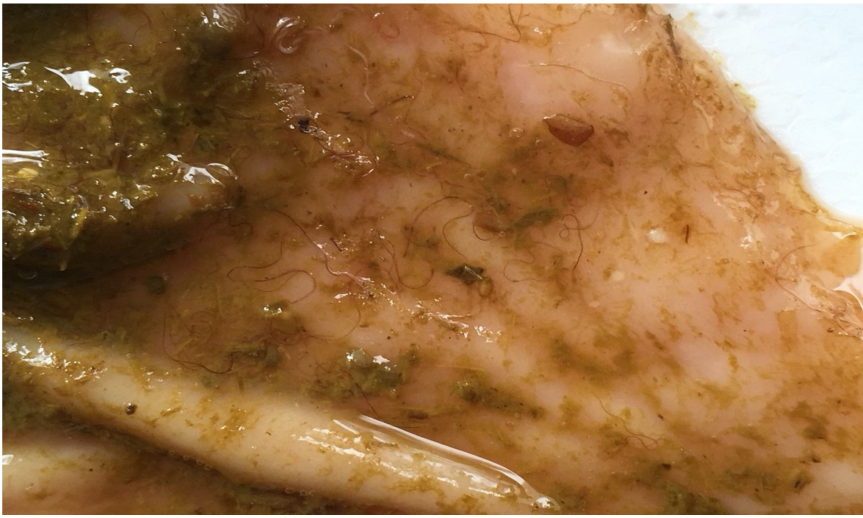
Figure 1. Haemonchus worms on the mucosa of the abomasum of an infected